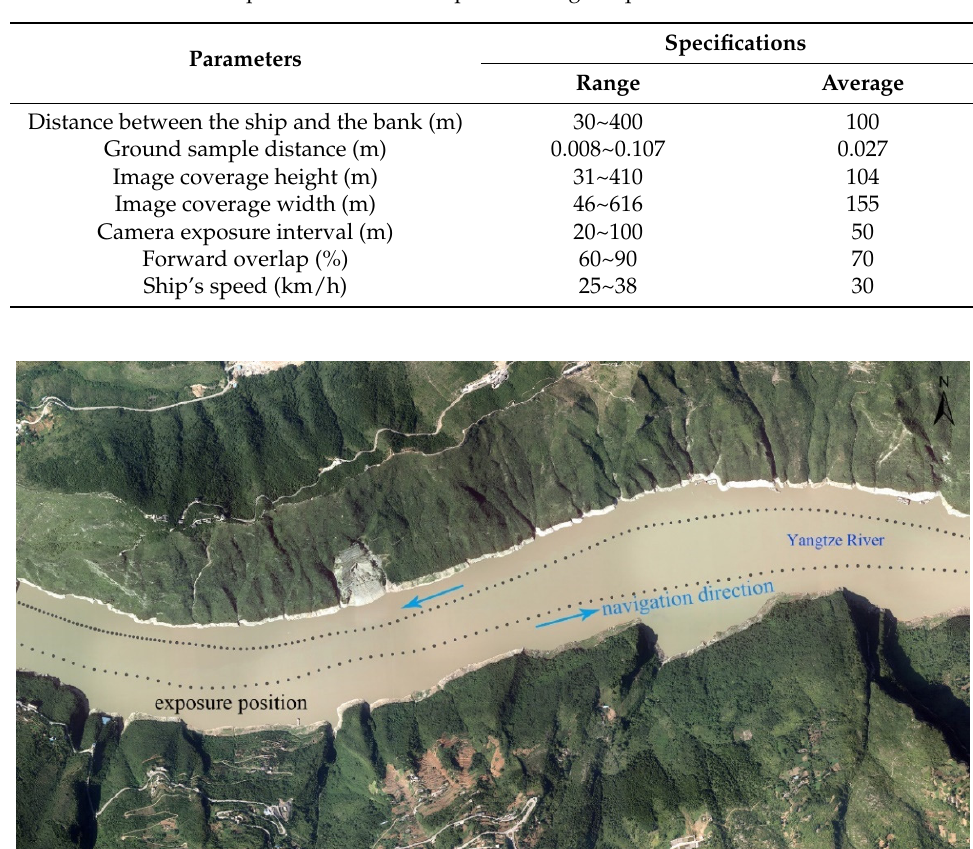
Table 2. Main technical parameters of the shipborne image acquisition.